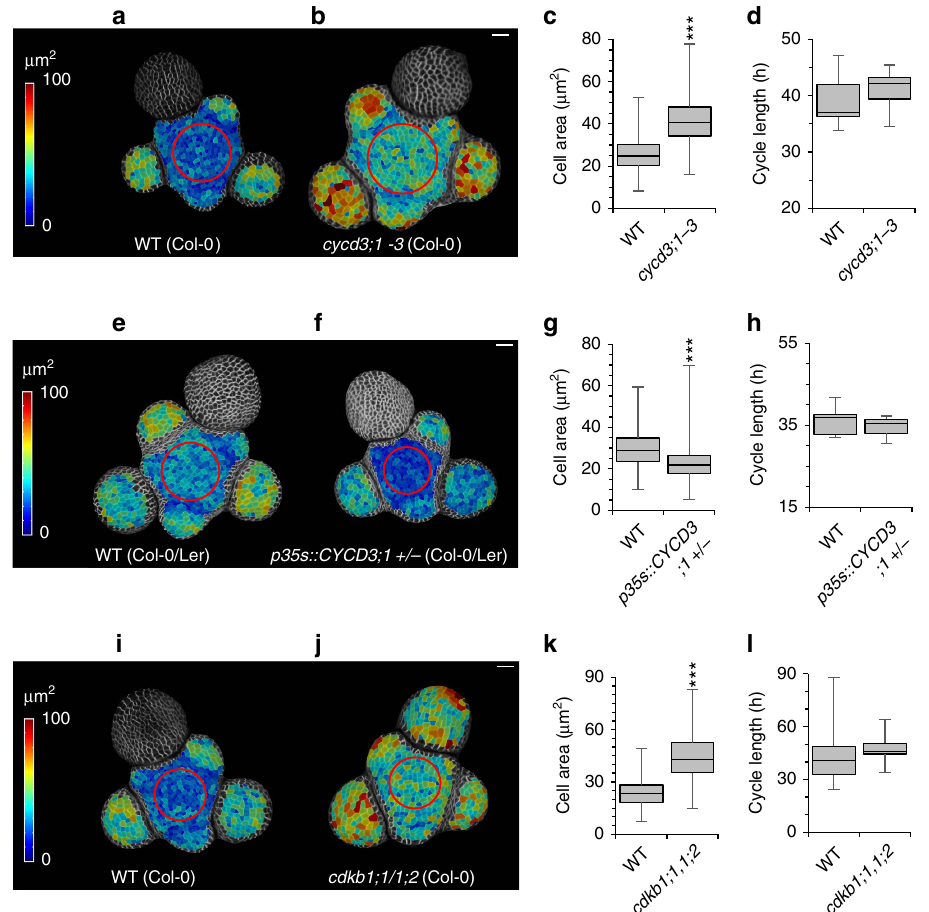
Figure 5 | Production of active CDK affects cell size but not cell cycle length. ( a , b ) Segmented surface projections of stems of wild type (Col-0) ( a ) and cycd3;1-3 triple mutant plants ( b ). Shading indicates outer surface area. Scale bars represent 20 m m. ( c ) Distribution of cell sizes in WT (Col-0) and cycd3;1-3 triple mutant plants. Boxes represent the interquartile range, whiskers represent total range. (GLMM, WT ¼ 1820 cells from 9 stems , cycd3;1-3 1482 cells from 8 stems, Effect size ¼ 15.87 m m 2 ± 0.61, P o 0.001) ( d ) Distribution of mean cell cycle length in WT (Col-0) and cycd3;1-3 triple mutant plants. Boxes represent the interquartile range, whiskers represent total range. ( t -test, WT 9 stems, cycd3;1-3 8 stems, t ¼ 0.867, df ¼ 13.5, p 0.4011) ( e , f ) Segmented surface projections of stems of wild type (Col-0/Ler) (e) and 35s::CYCD3;1 þ / (cid:2) plants ( f ). Shading indicates outer surface area. Scale bars represent 20 m m. ( g ) Distribution of cell sizes in WT (Col-0/Ler) and 35s::CYCD3;1 ± plants. Boxes represent the interquartile range, whiskers represent total range. (GLMM, WT 769 cells from 5 stems, 35s::CYCD3;1 ± 1320 cells from 7 stems, Effect size 4.73 m m 2 ± 0.39, P o 0.001) ( h ) Distribution of mean cell cycle length in WT (Col-0/Ler) and 35s::CYCD3;1 ± plants. Boxes represent the interquartile range, whiskers represent total range. ( t -test, WT 5 stems, 35s::CYCD3;1-3 7 stems, t ¼ (cid:2) 0.7899, df ¼ 6718, P ¼ 0.4566) ( i , j ) Segmented surface projections of stems of WT (Col-0) ( i ) and cdkb1;1/1;2 double mutant plants ( j ). Shading indicates outer surface area. Scale bars represent 20 m m. ( k ) Distribution of cell sizes in WT (Col-0) and cdkb1;1/1;2 double mutant plants. Boxes represent the interquartile range, whiskers represent total range. (GLMM, WT ¼ 894 cells from 13 stems, cdkb1;1/1;2 ¼ 593 cells from 11 stems, Effect size ¼ 20.24 m m 2 ± 0.53, P o 0.001) ( l ) Distribution of mean cell cycle length in WT (Col-0) and cdkb1;1/1;2 double mutant plants. Boxes represent the interquartile range, whiskers represent total range. ( t -test, WT ¼ 13 stems, cdkb1;1/1;2 ¼ 11 stems, t ¼ 0.6448, df ¼ 16.766, P ¼ 0.5278) *, **, *** indicate a significance at the 0.05, 0.01 and 0.001 levels,